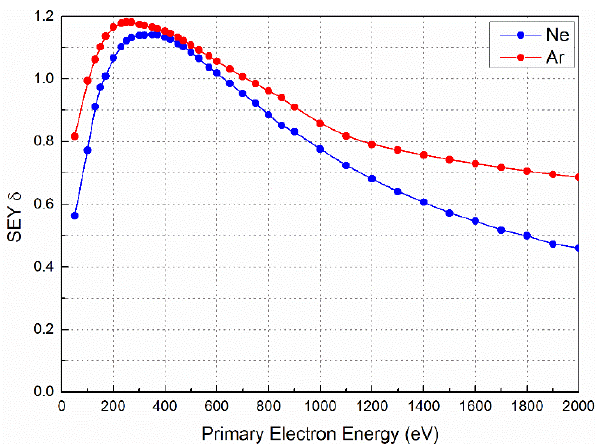
Figure 7. The SEY curves as a function of primary energy for amorphous carbon coatings produced with various working gases Ne (blue line) and Ar (red line).